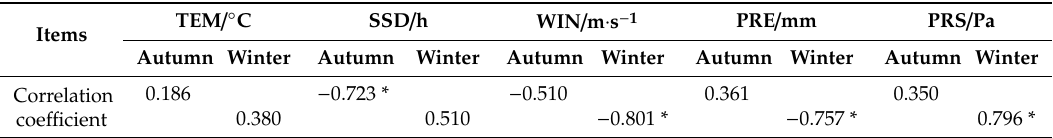
Table 3. Pearson correlation coe ffi cients between the meteorological variables and the algal bloom area from 2008 to